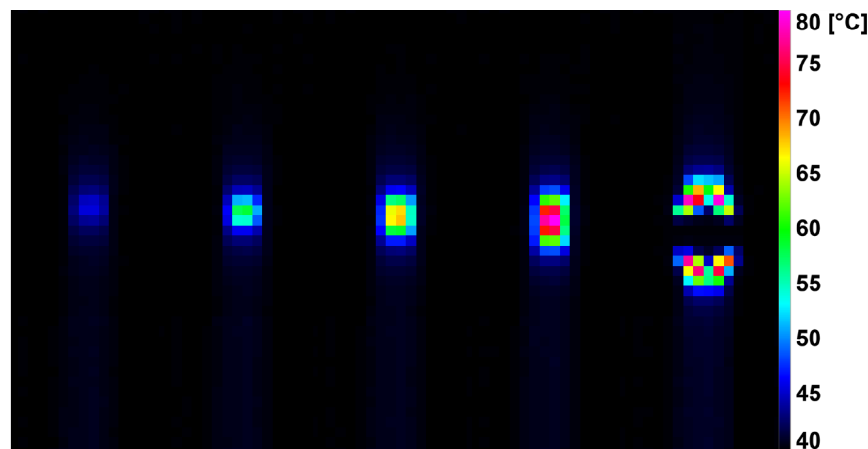
Figure 6. Deformation process of H1 evaluated using IR thermography.